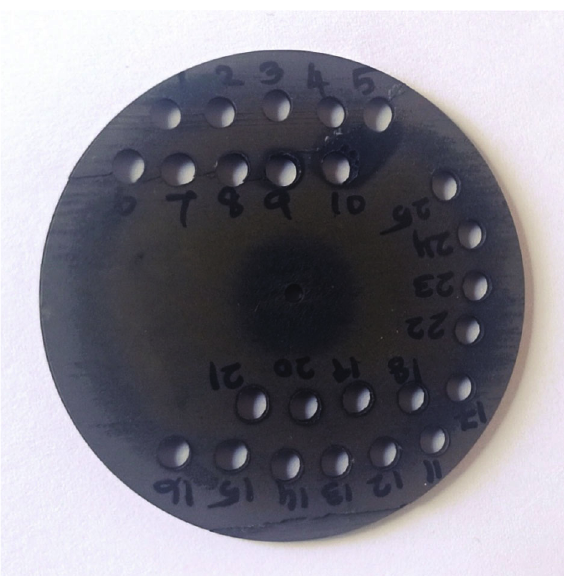
– TiN workpiece. N 3 4